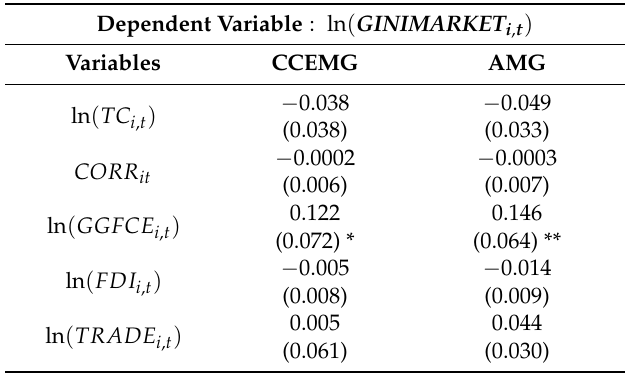
Table 6. Mean Group Type Estimations (the market Gini Coefficient and Total Private